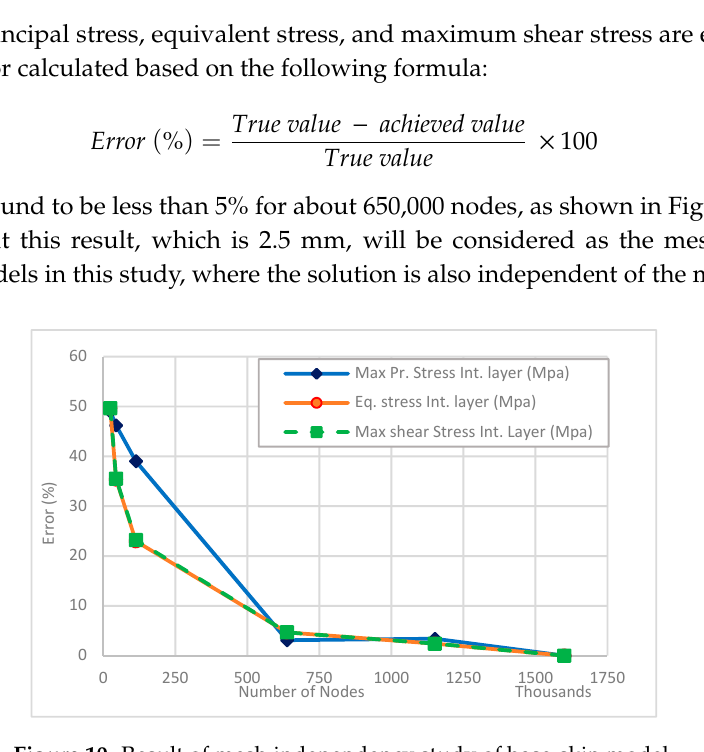
Figure 10. Result of mesh independency study of base-skin model.